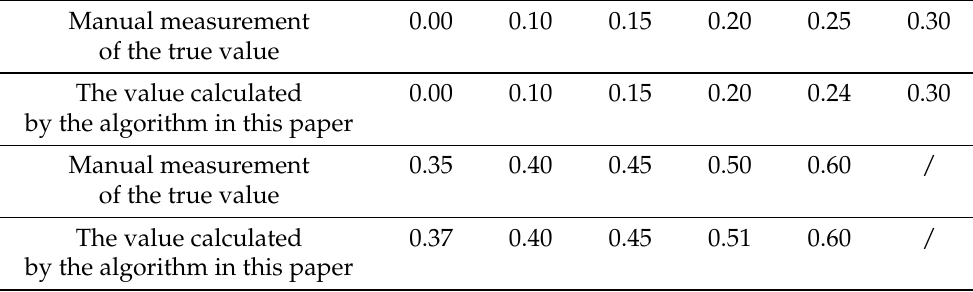
Table 8. Measurement results under uneven lighting.